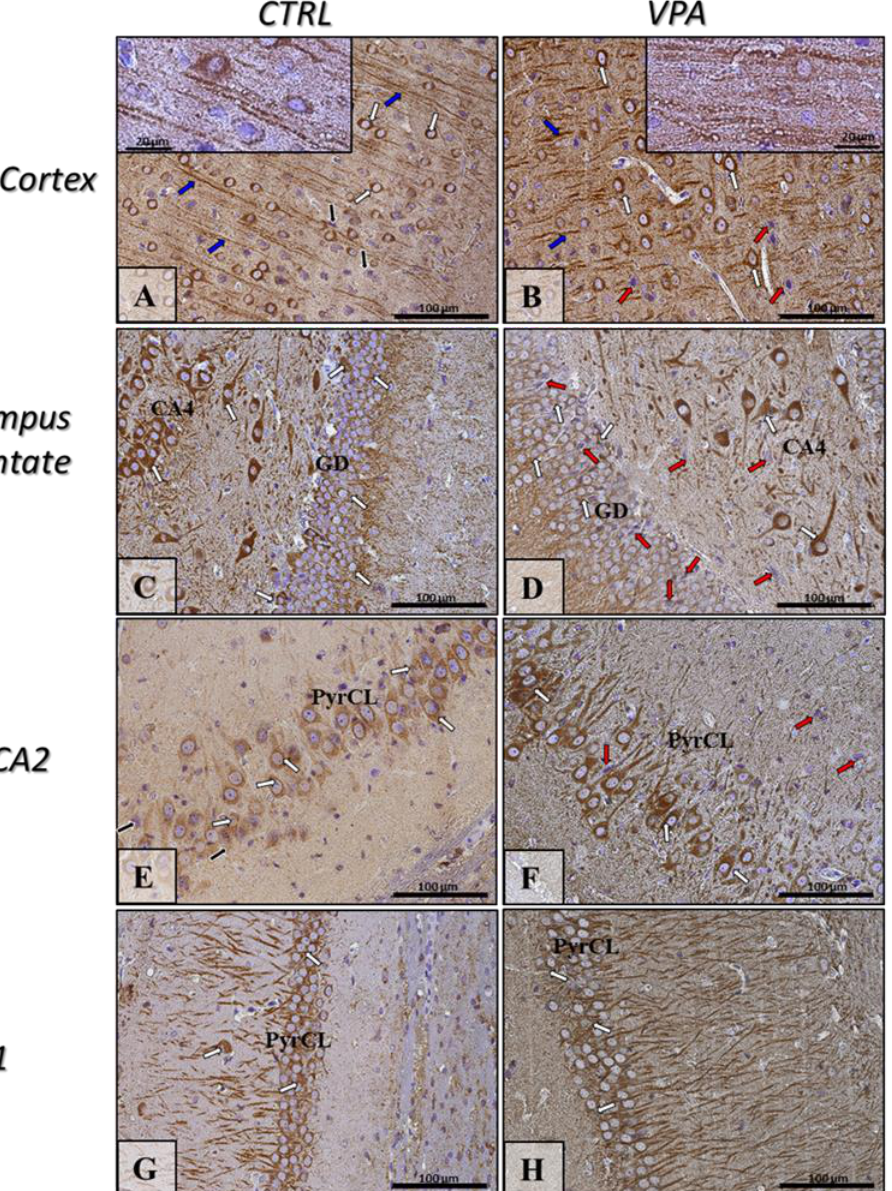
Figure 8. The effect of prenatal exposure to VPA on the immunoreactivity of Tau phosphorylated at (Ser416) in the rat brain. Representative microphotography showing immunoexpression of pTau(Ser416) in the cerebral cortex and hippocampus proper (GD—Gyrus Dentate, CA1-CA4—the regions of Cornu Ammonis) of control rats ( A , C , E , G ) and VPA-treated rats ( B , D , F , H ). IHC reaction. Scale bar: 100 µm and 20 µm in the insertion of A and B (objective magnification ×40, ×100, respectively). pTau(Ser416)-immunopositive perikaryon (white arrows) and their processes (blue arrows); red arrows—pTau(Ser416)-immunonegative neurons with pathologic phenotype (chromatolysis—collapsed cell nucleus as a result of the negatively affected cytoskeletal network because of degradation of Nissl bodies and disturbances of cell metabolism); PyrCL—Pyramidal Cell Layer of CA1-CA3 regions. Representative pictures from n = 11 (CTRL) and n = 9 (VPA) independent experiments in both the hippocampus and cerebral cortex are presented.